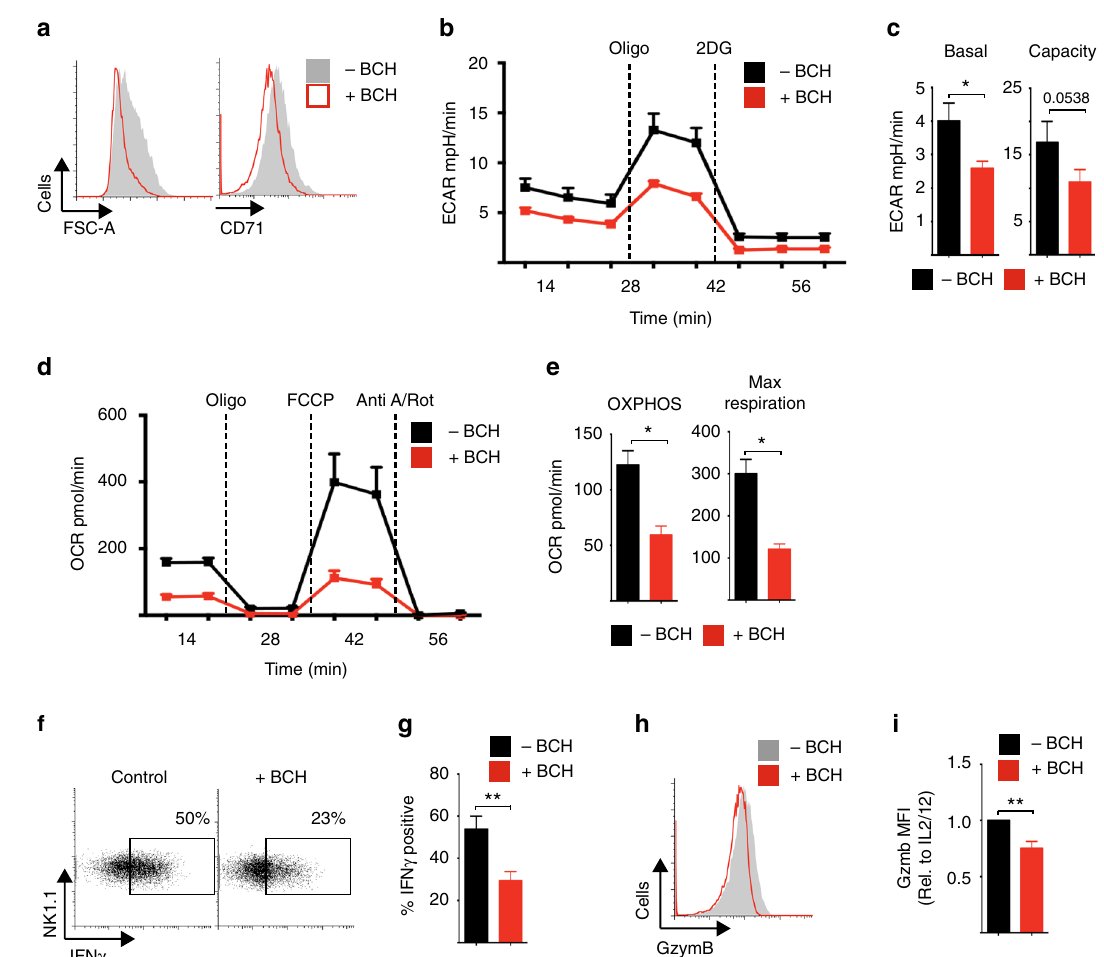
Fig. 5 SLC7A5 is required for NK cell metabolic and functional responses. a – i NK cells were stimulated with IL-2/IL-12 in the presence or absence of BCH (25 mM) for 18 h as indicated. a FSC-A and CD71 expression were analysed by fl ow cytometry. b , c Analysis of extracellular acidi fi cation rate (ECAR) of NK cells to assess basal glycolytic rate and glycolytic capacity. d , e Analysis of NK cell oxygen consumption rate (OCR) to assess rates of OXPHOS and maximal respiration. f , g IFN γ and h , i granzyme B expression were analysed by fl ow cytometry. Data are mean ± s.e.m. of 4 ( c , e ) or 5 ( g , i ) experiments or representative of 4 ( b , d ) or 5 ( a – h ) individual experiments. b – e Data were normalised to 200,000 cells. Statistical analysis was performed using Student's t -test ( c – g ) or a one-sample t -test vs. a theoretical value of 1 ( i ); * p < 0.05, ** p < 0.01. Oligo oligomycin, 2DG 2-deoxyglucose, Anti A antimycin A, Rot rotenone, FCCP carbonyl cyanide-4-(tri fl